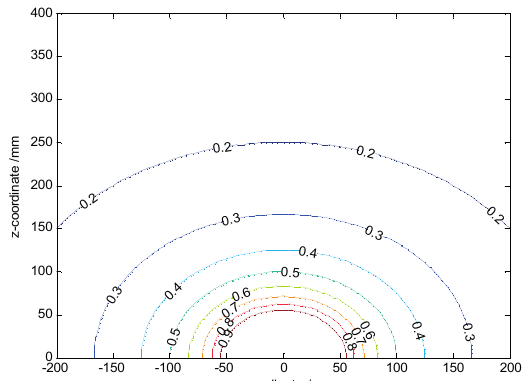
Figure 5. The contours of the spatial